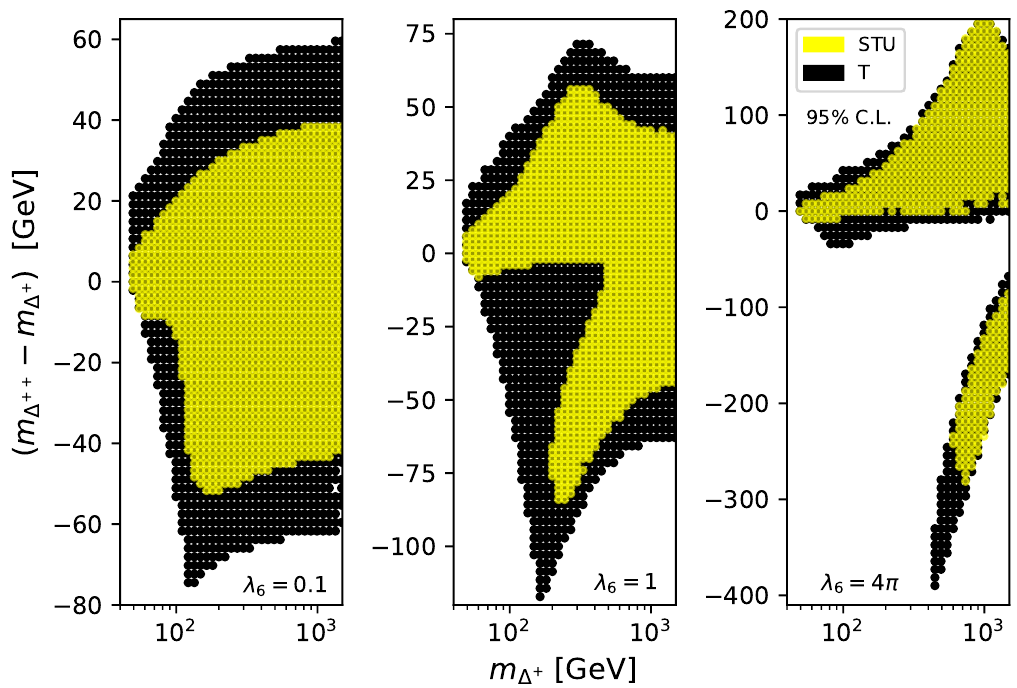
Figure 7 . 95% C.L. allowed regions in the ( m (cid:1) + , m (cid:1) ++ (cid:0) m (cid:1) + ) plane for three di(cid:11)erent choices of (cid:21) 6 (from left to right, (cid:21) 6 = 0 : 1 ; 1 ; 4 (cid:25) ) in the Inert Triplet model. Yellow regions